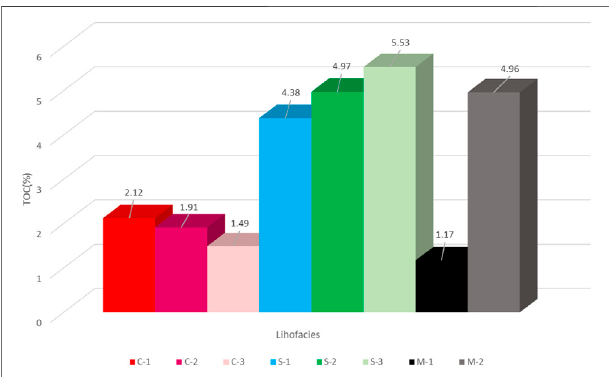
FIGURE 11 | Comparison of TOC content of different